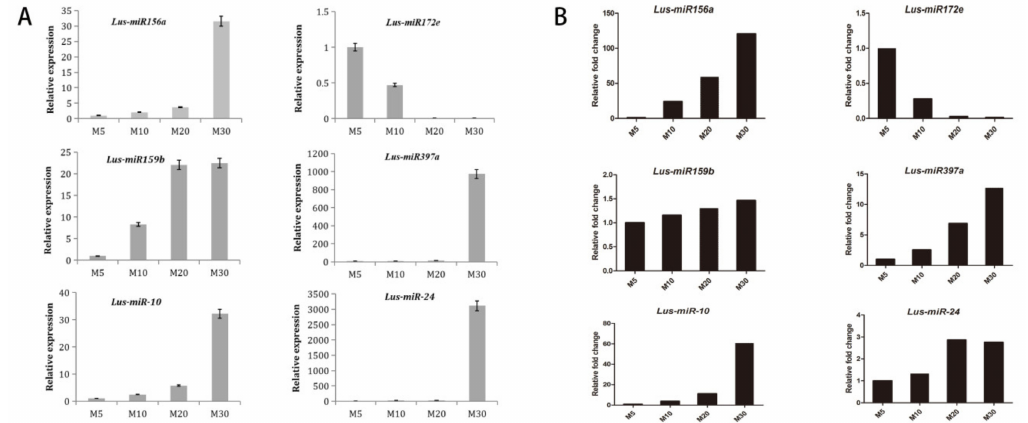
Figure 4. Expression patterns of miR156a , miR172e , miR159b , miR397a , Lus-miR-10 and Lus-miR-24 in seed developmental stages (M5, M10, M20 and M30) of qPCR and Next-generation sequencing (NGS) data. Error bars indicated standard deviation of three replicates. ( A )The results of qPCR, ( B ) The results from NGS